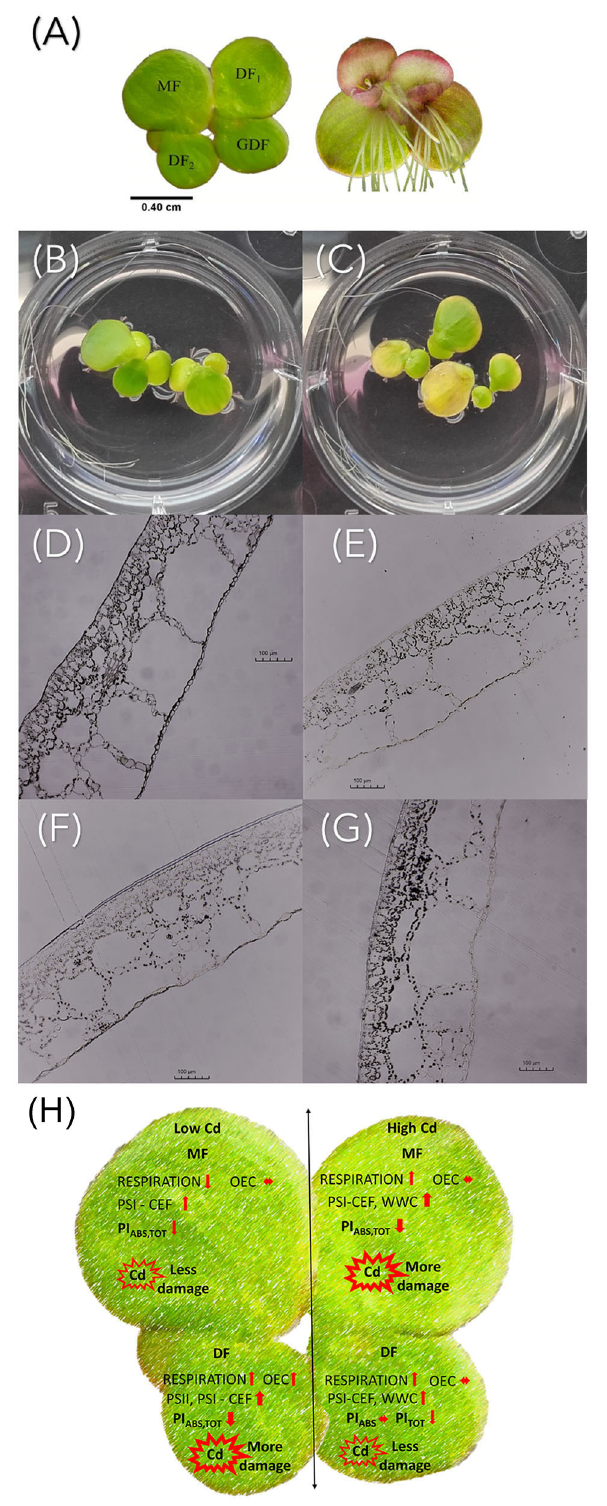
FIGURE 9 | (A) S. polyrhiza four-frond colony. MF, mother frond; DF 1 and DF 2 , first and second daughter fronds; GDF, granddaughter frond. Visual